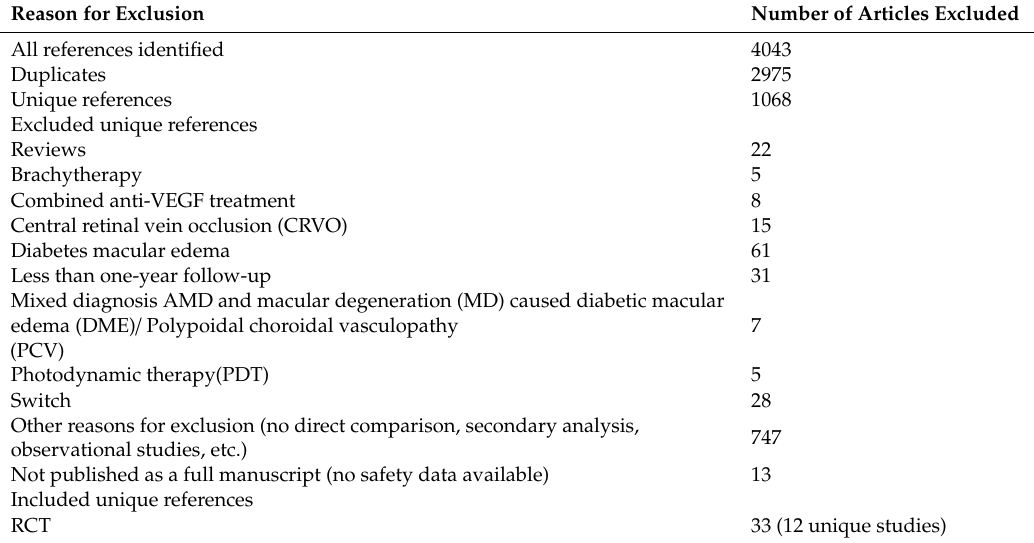
Table 2. Reasons for abstract